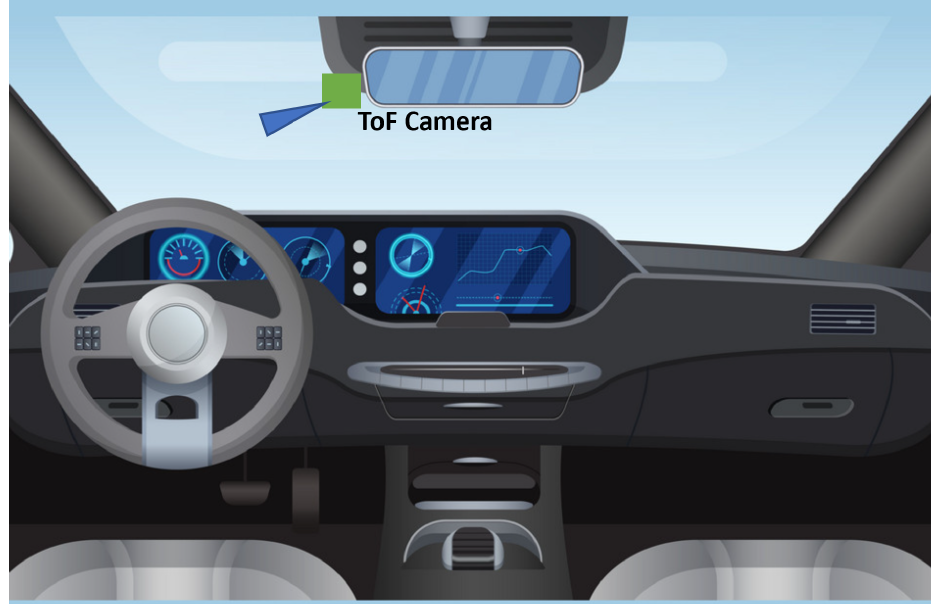
Figure 1. Experimental configuration for HR/RR measurements in a vehicle with a ToF